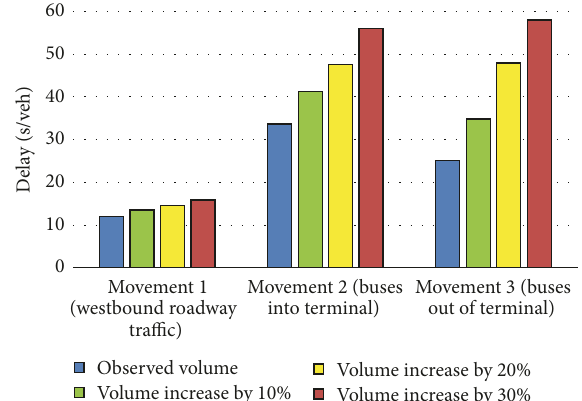
Figure 10: Effects of increasing traffic flow on average delay per